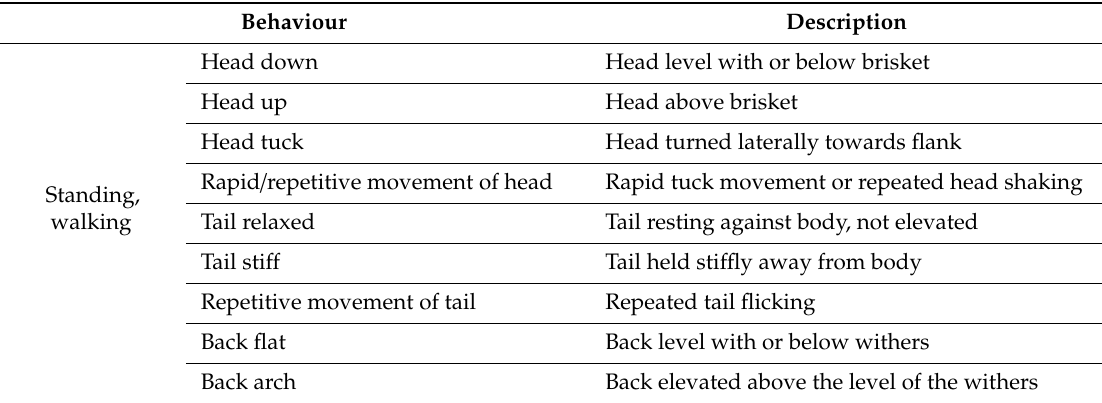
Table 2. Ethogram developed for behavioural observations of heifers following rectal palpation and Willis dropped ovary technique spaying with or without meloxicam and topical anaesthetic, modified from Petherick et al. [2].